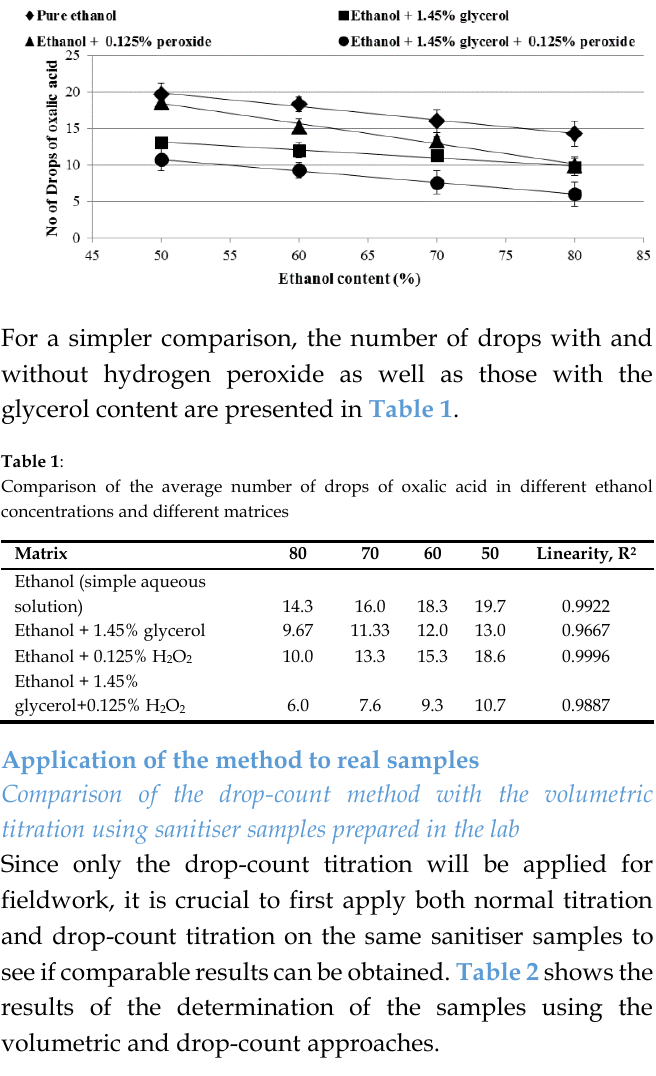
Drop-count titration of alcohol in different matrices with oxalic acid